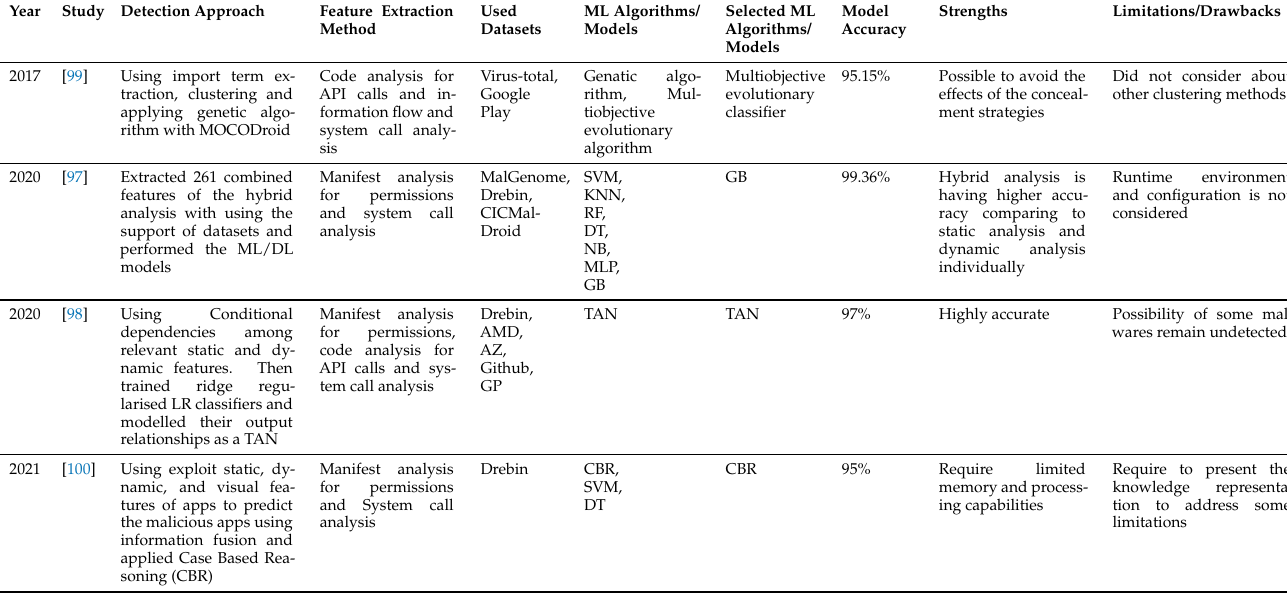
Table 7. Hybrid analysis based malware detection approaches (model accuracy is above